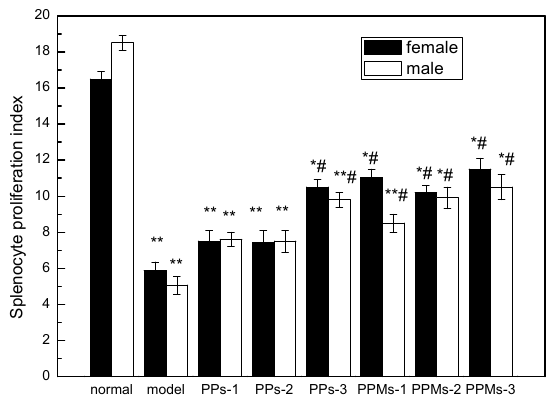
Figure 9. Effect of PP and PPM on the proliferation of splenic lymphocytes; the irradiation dose was 6 Gy. * p < 0.05 and ** p < 0.01 compared with the normal group; # p < 0.05 compared with the model group(mean ± SD, n = 6).